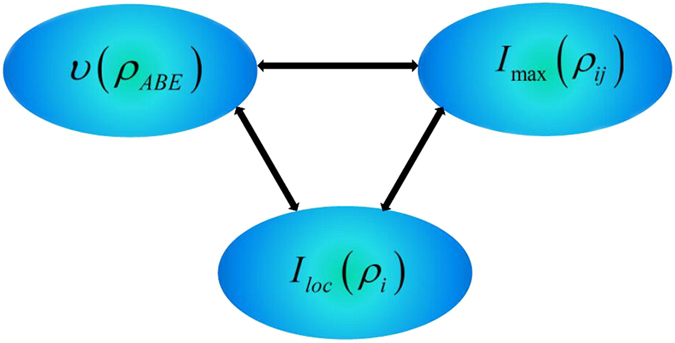
The sketch of the information flow among the genuine tripartite correlations υ(ρABE), maximal bipartite correlations Imax(ρij) and local state information Iloc.